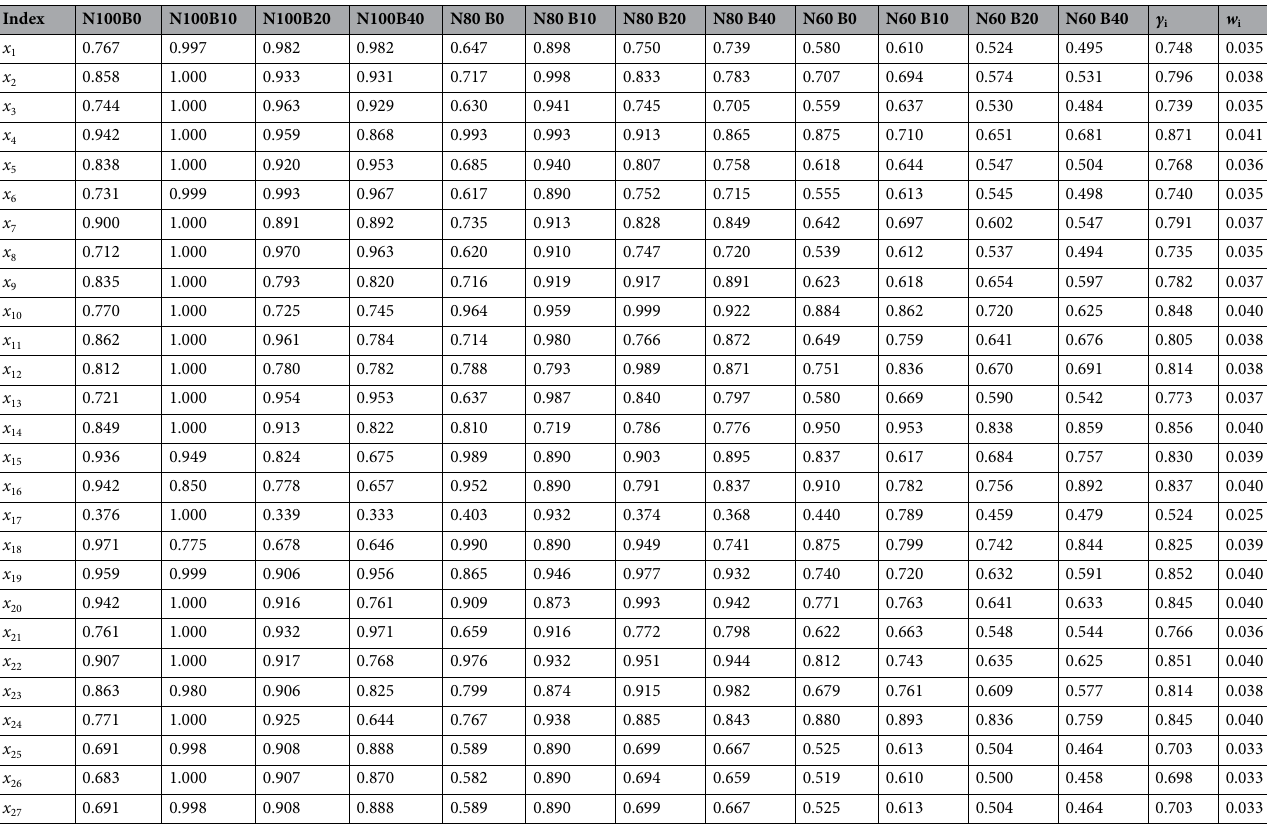
Table 3. Correlation